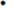
Lung T1 as a function of age and PY for all subjects.The example line shows the correlation between median lung T1 and age for smokers (●) and never smokers (○), indicating that lung T1 shortens with ageing (p<0.01, r = -0.52). The smoking history of the current smokers is visualized with increased size of the dots (• = 1–10 PY, • = 11–20 PY, • = 21–30 PY and • = 31–40 PY).